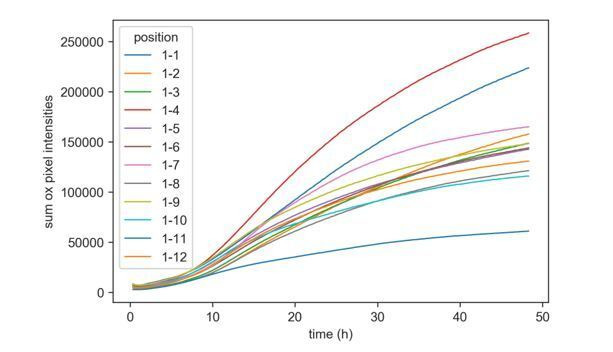
Examples of raw growth curves obtained with pyphe setup.Shown are 12 growth curves from the first row of a 1536 plate of 57 S. pombe wild strains (same data as Figure 2 in manuscript) analysed with pyphe-quantify in timecourse mode.